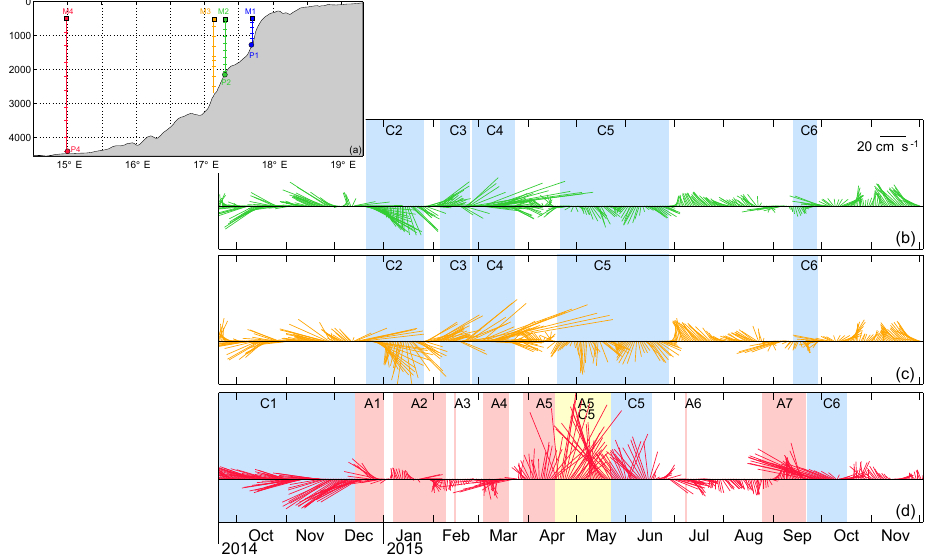
Figure 5. (a) Vertical scheme of the mooring lines positions along the latitude 34.5 ◦ S. The squares represent the upward-looking ADCP positions, the small horizontal lines indicate the SBE MicroCAT’s sensors and the circles at the bottom show the CPIES. Temporal evolution of the current vector stick plot at M2 (b) , M3 (c) and M4 (d) . One vector per day is shown. The shaded areas show the eddy events defined with altimetry data (red: anticyclonic eddies; yellow: dipole event; blue: cyclonic eddies).